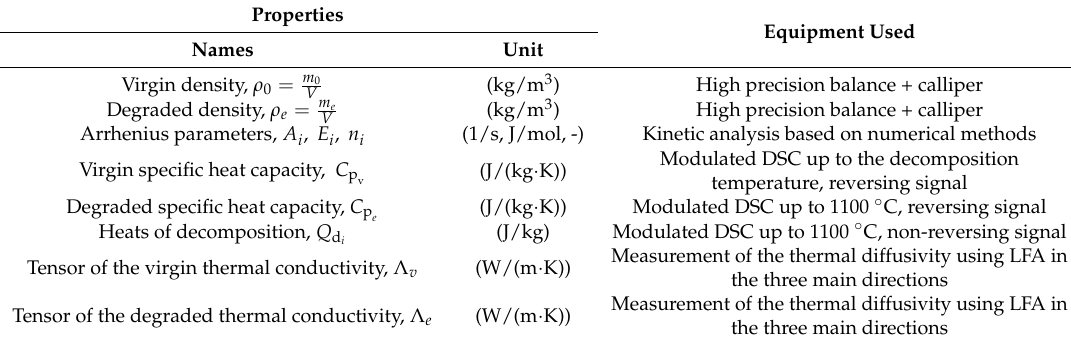
Table 2. Equipment used to determine the input properties necessary for